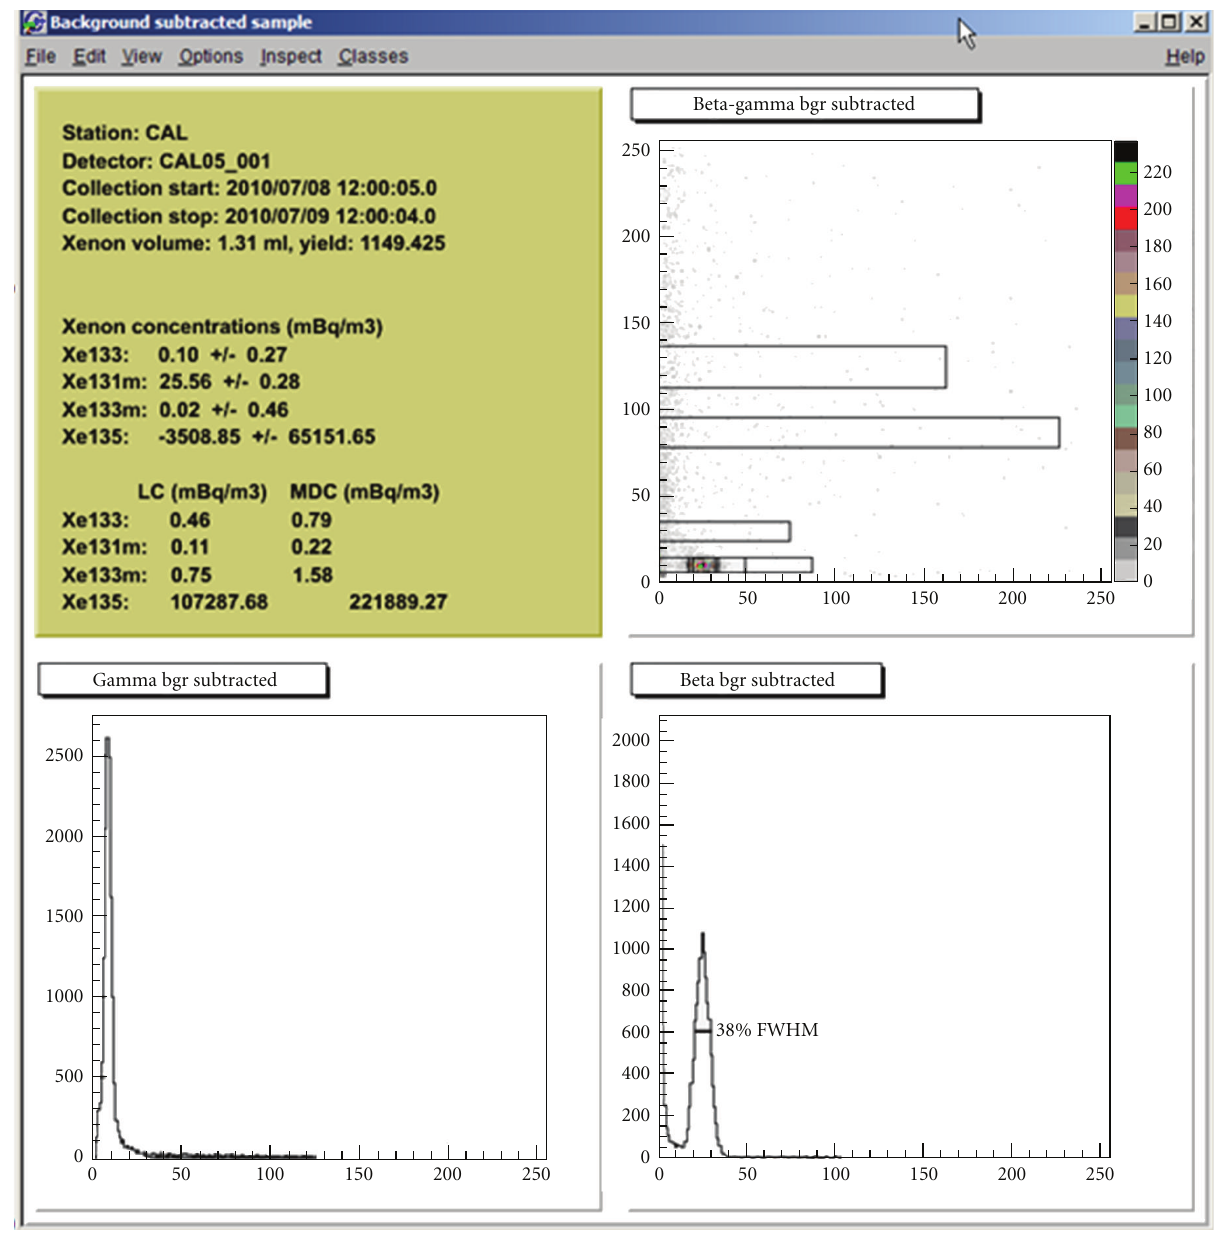
Figure 1: An experimentally determined pure 131m Xe standard beta-gamma coincidence spectrum by PW5 detector. The analyzed radioxenon concentration (a). Top view of the 3D histogram regarding the beta-gamma coincidence decay events detected by PhosWatch detector (b). The 2D histograms of energy deposition events at CsI(Tl) (c) and BC404